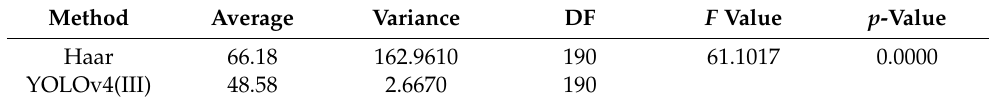
Table 8. Two samples for variances using their average cases.